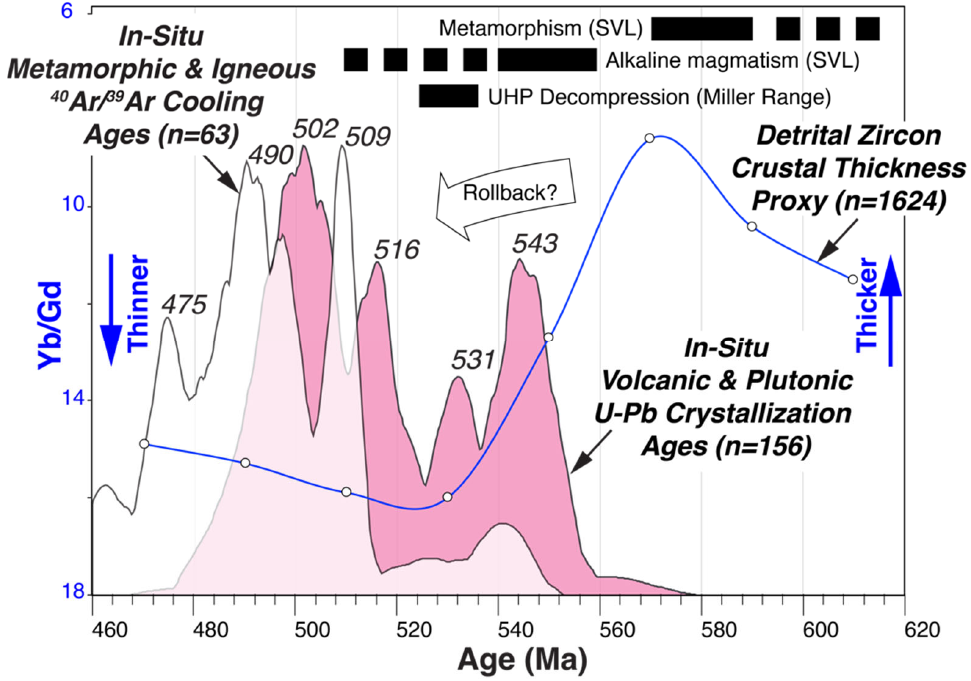
Figure 13. Average detrital zircon Yb/Gd ratios (20 Myr time brackets) with respect to the timing of metamorphism associated with crustal thickening in south Victoria Land [101], alkaline volcanism in south Victoria Land [91], and decompression of ultra-high-pressure metamorphic rocks in the central Transantarctic Mountains [108], as well as stacked kernel-density-estimation diagrams [73] showing in situ igneous and metamorphic 40 Ar/ 39 Ar cooling ages and igneous U-Pb crystallization ages falling within the 620–460 Ma time period in the Ross orogenic belt from South Victoria Land through the Queen Maud Mountains. Note that the zircon Yb/Gd ratio decreases upwards correlating with increasing crustal thickness. Detrital zircon Yb/Gd data include all zircons regardless of concordance with Th/U > 0.1 (~igneous proxy) and Th, U, Y, Yb, and Gd values > 0. Interpreted zircon ages are 206 Pb/ 238 U ages for grains with 206 Pb/ 207 Pb ages < 1500 Ma. 40 Ar/ 39 Ar cooling ages are compiled from data presented in this paper, as well as [37,45,46,48,51,52,54,79–83]. U-Pb igneous crystallization ages are presented in [33–38,44–48,82,84–99].